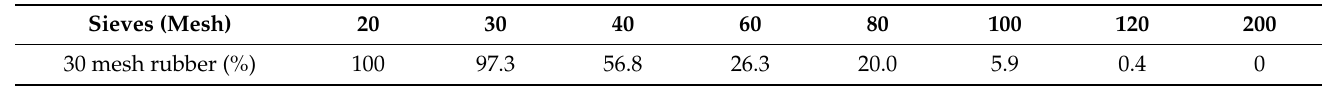
Table 1. The sieved results of the crumb rubber sample with 30 mesh. Sieves